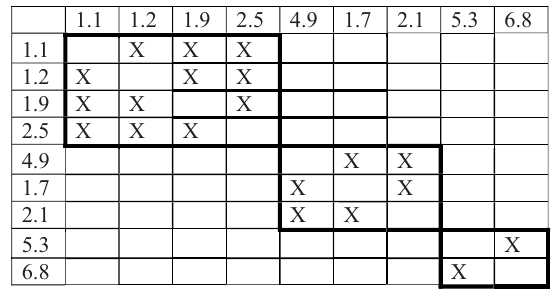
FIG. 6. Sample questions-asked matrix example demonstrating the nonuniformity of the questions if grouped purely on the ques- tions